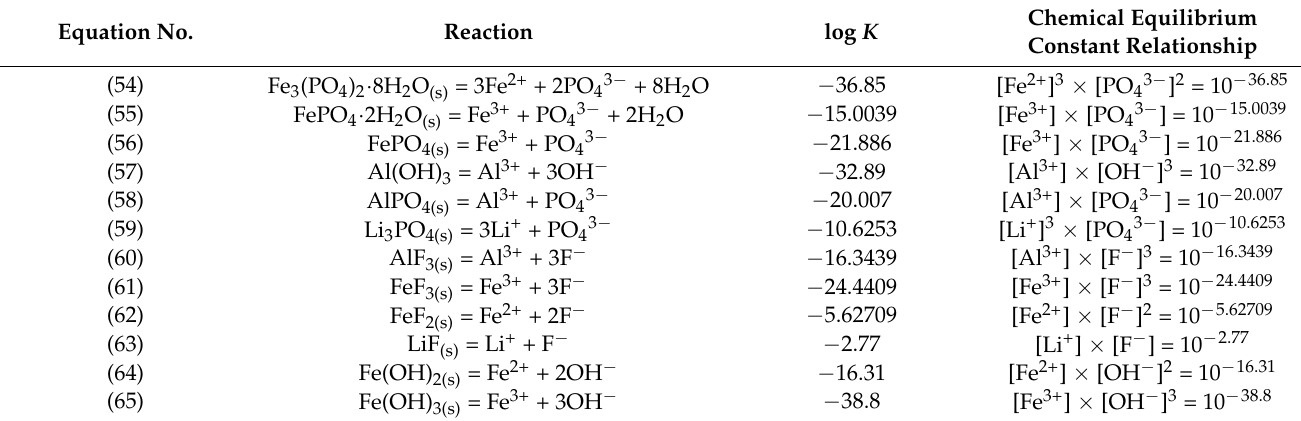
Table 4. Solid-state reactions and their equilibrium constant of Li + –Fe 2+ /Fe 3+ –Al 3+ –PO 43 − –SO 42 − –F − –H 2 O system (298 K)